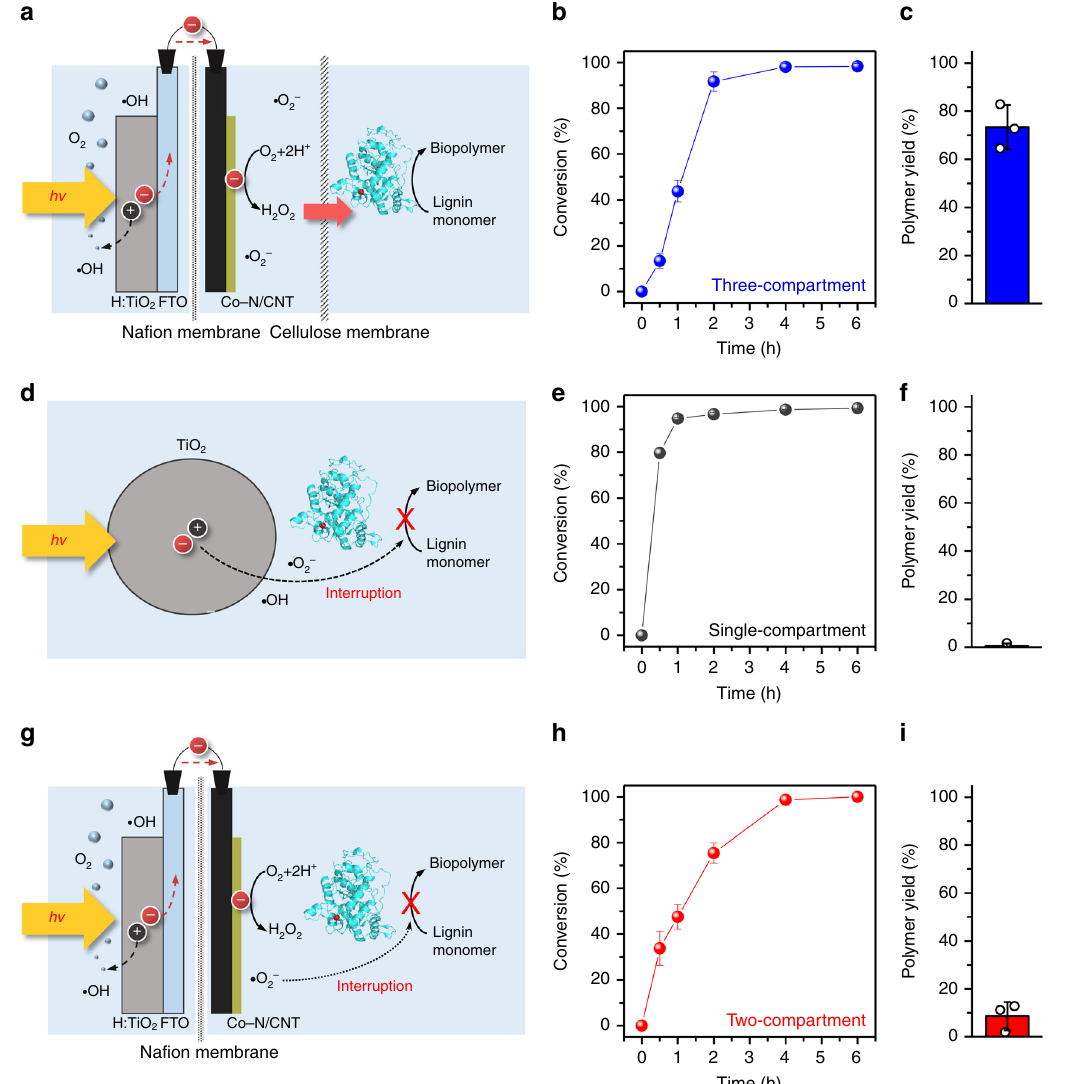
Fig. 4 Reactor con fi gurations and photo-electro-biochemical biopolymer synthesis. a , d , g Schematic representations of the: ( a ) three-compartment photo- electro-biochemical system, ( d ) single-compartment powder-based photo-biochemical system, and ( g ) two-compartment photo-electrochemical system used for biopolymer synthesis. b , e , h Conversion percentage of coniferyl alcohol over time and c , f , i polymer yield after 6 h of reaction of the three- compartment photo-electro-biochemical system ( b , c ), single-compartment powder-based photo-biochemical system ( e , f ), and two-compartment photo- electrochemical system ( h , i ). Error bars indicate the standard